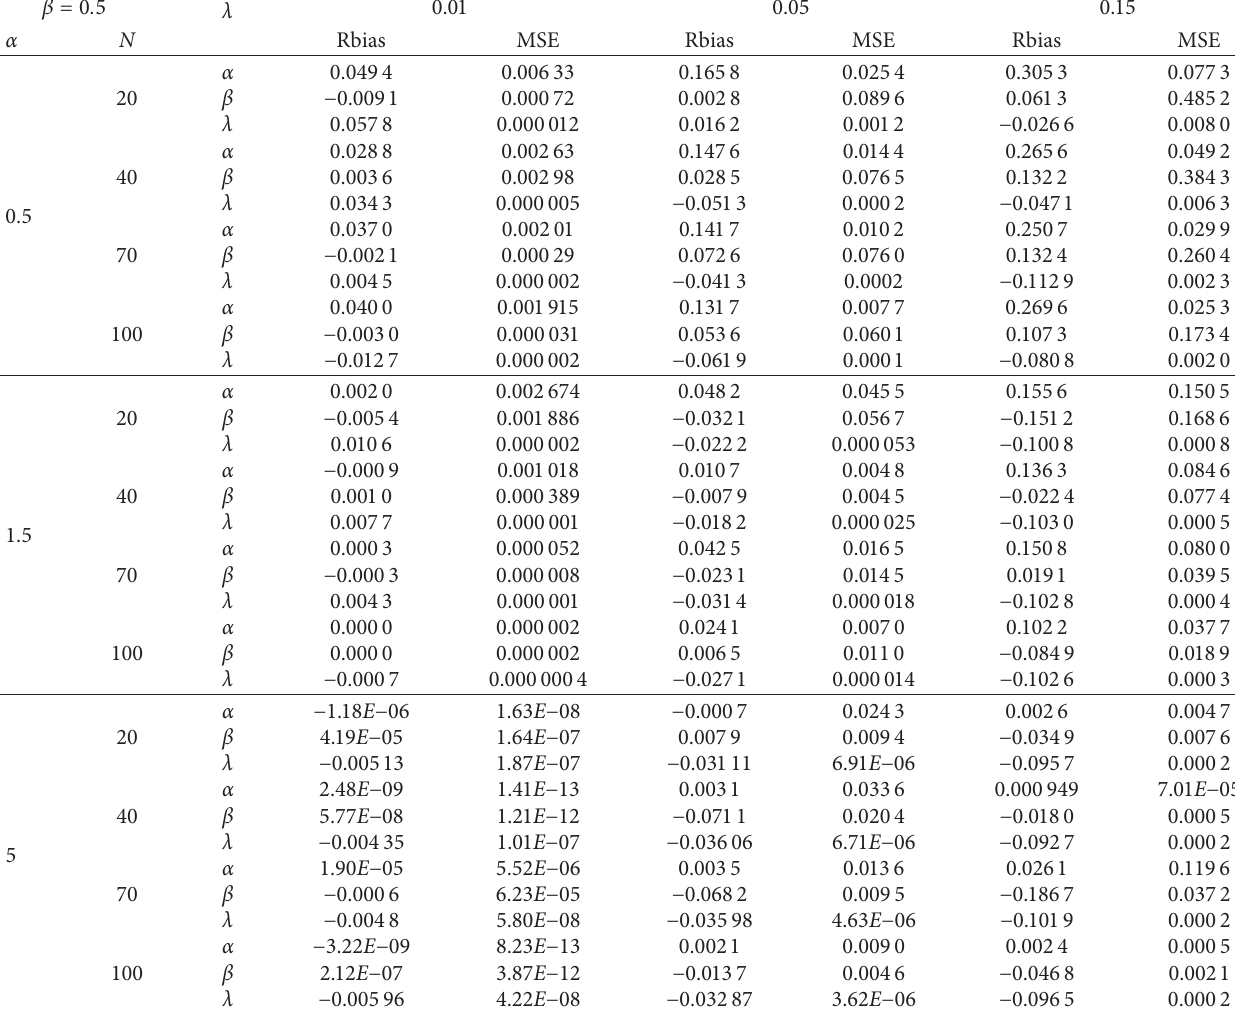
Table 2: Rbias and MSE for parameter of DEOWE distribution by using MLE when β � 0 . 5. β � 0 . 5